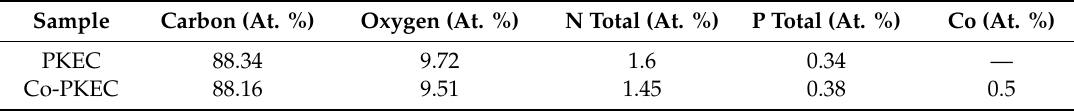
Figure 6. N 2 adsorption desorption isotherm and pore size distribution of PKEC ( A , B ) and Co-PKEC ( C , D ). Table 2. Surface chemical composition of PKEC and